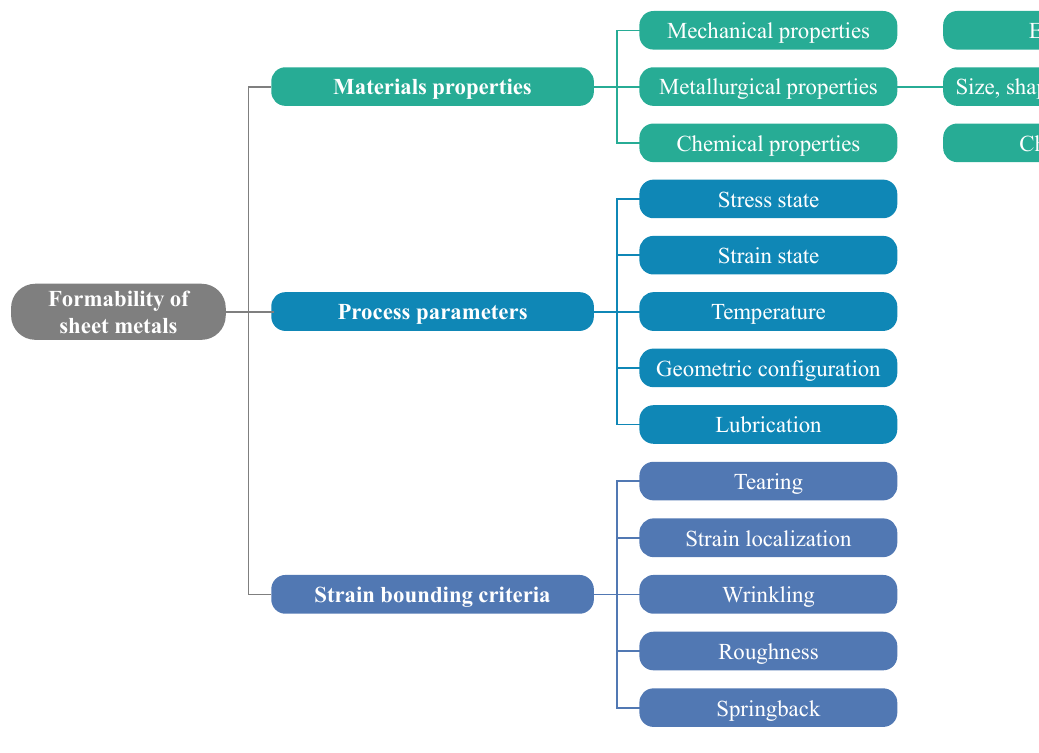
Figure 24. Factors affecting the formability of sheet metals. FLD is considered as a critical tool used for evaluating sheet metal’s formability. Keeler proposed the negative region of the minor strain of FLD, then Goodwin [320]